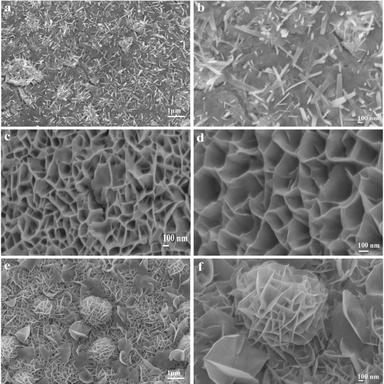
SEM images of MnO2 (a and b), NiMoO4 (c and d), and NiMoO4@MnO2 (e and f).